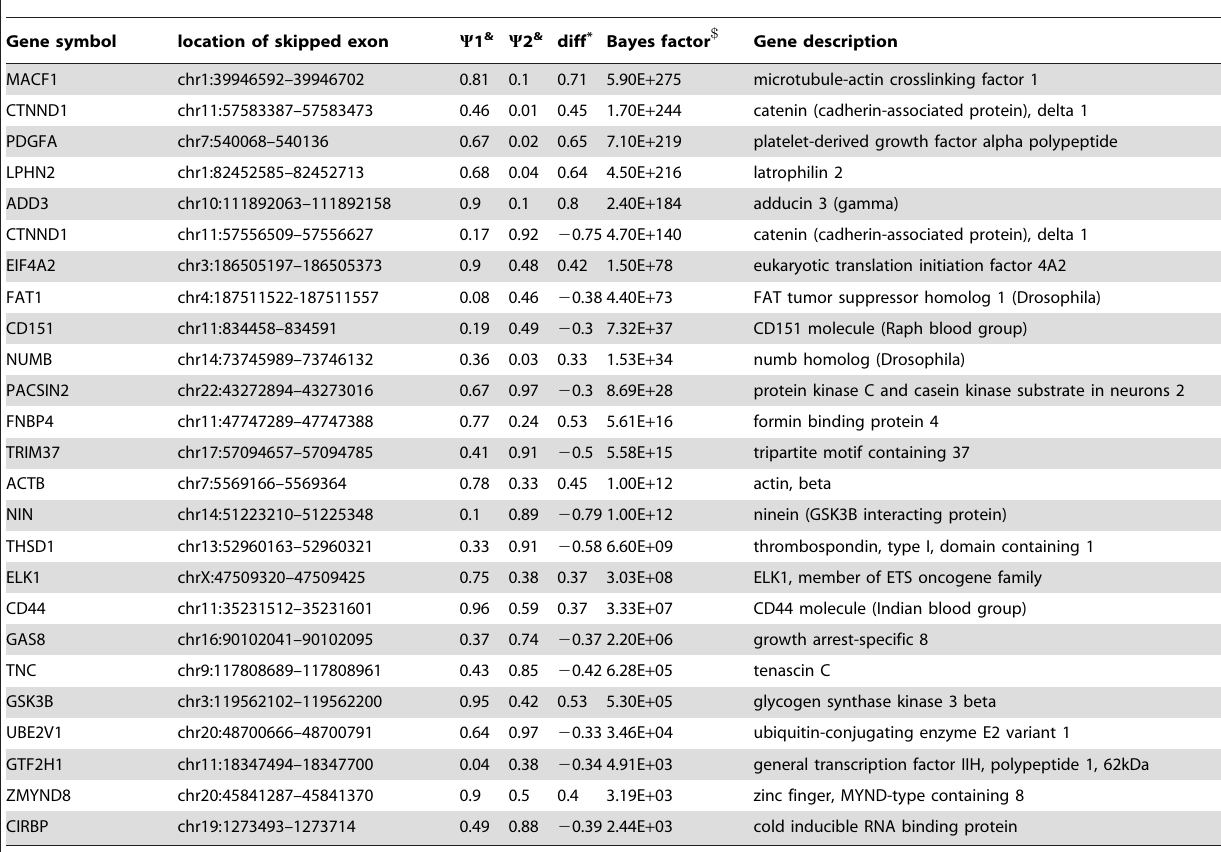
Table 6. Differential exon skipping events in cancer-associated